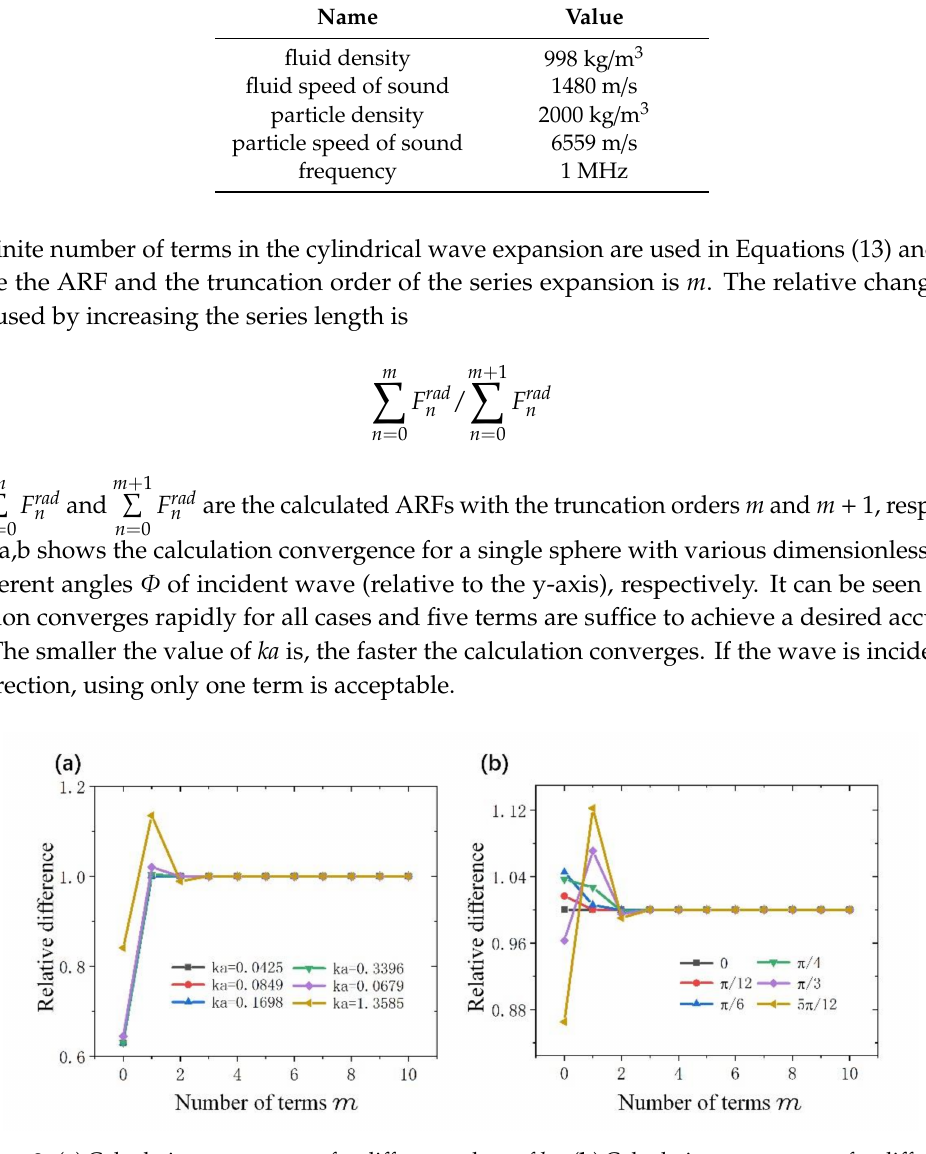
Figure 2. ( a ) Calculation convergence for di ff erent values of ka . ( b ) Calculation convergence for di ff erent incident